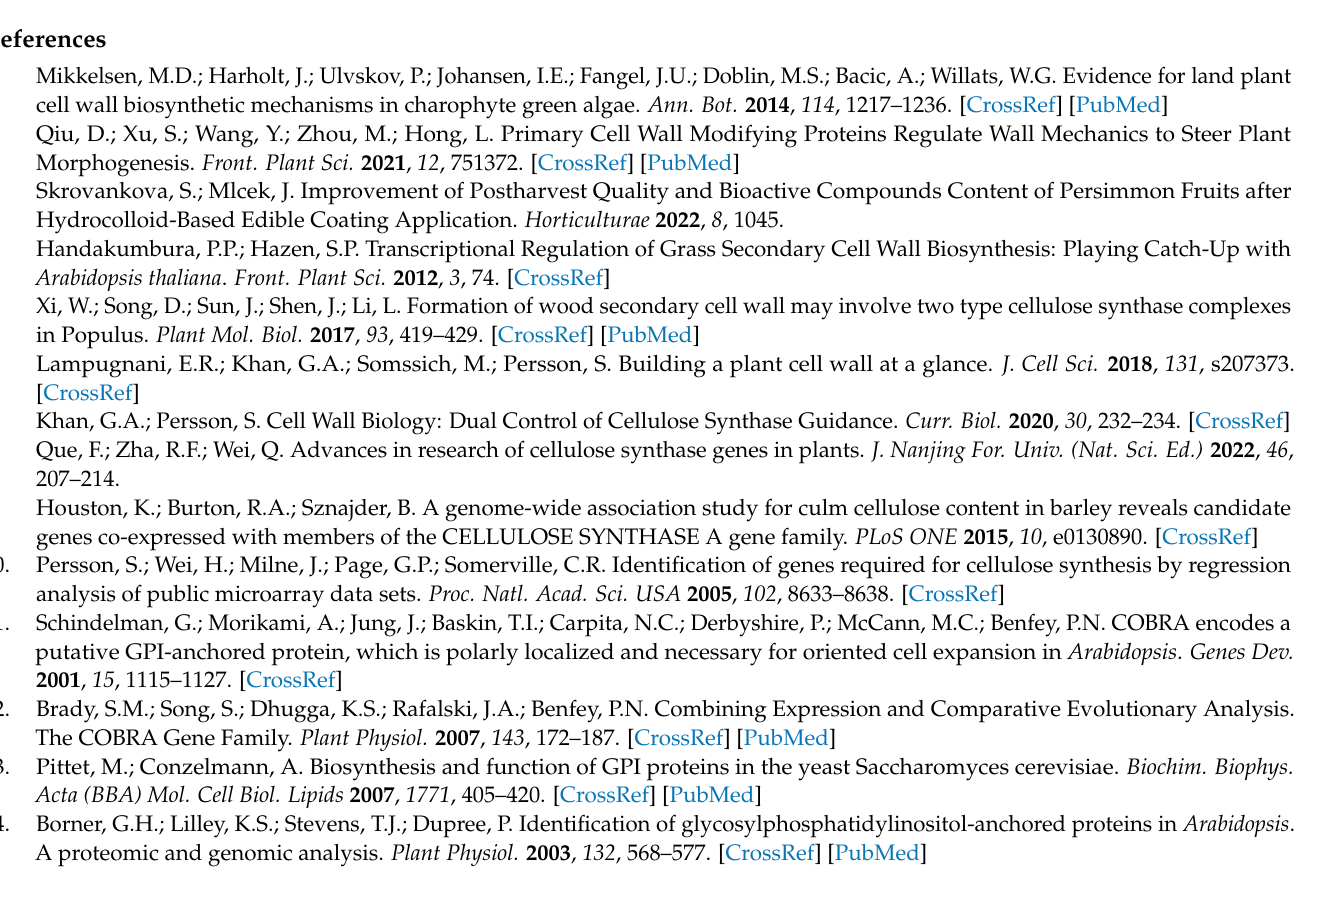
sequences of LcCOBLs; Figure S2: Prediction results of GPI modification sites of protein sequences of LcCOBL; Figure S3: Prediction results of signal peptides of protein sequences of LcCOBL; Figure S4: Prediction results of transmembrane domains of LcCOBL proteins; Figure S5: ClustalW was used for multi-sequence alignment of LcCOBL protein sequences; Figure S6: Amino acid sequences of each motif; Figure S7: Subcellular localization of LcCOBL2, 4 proteins in L. chinense calli and in onion epidermal cells; Table S1: Protein names and sequences of COBL; Table S2: Primer sequences of LcCOBL proteins for subcellular localization; Table S3: Primer sequences of LcCOBLs and reference genes in